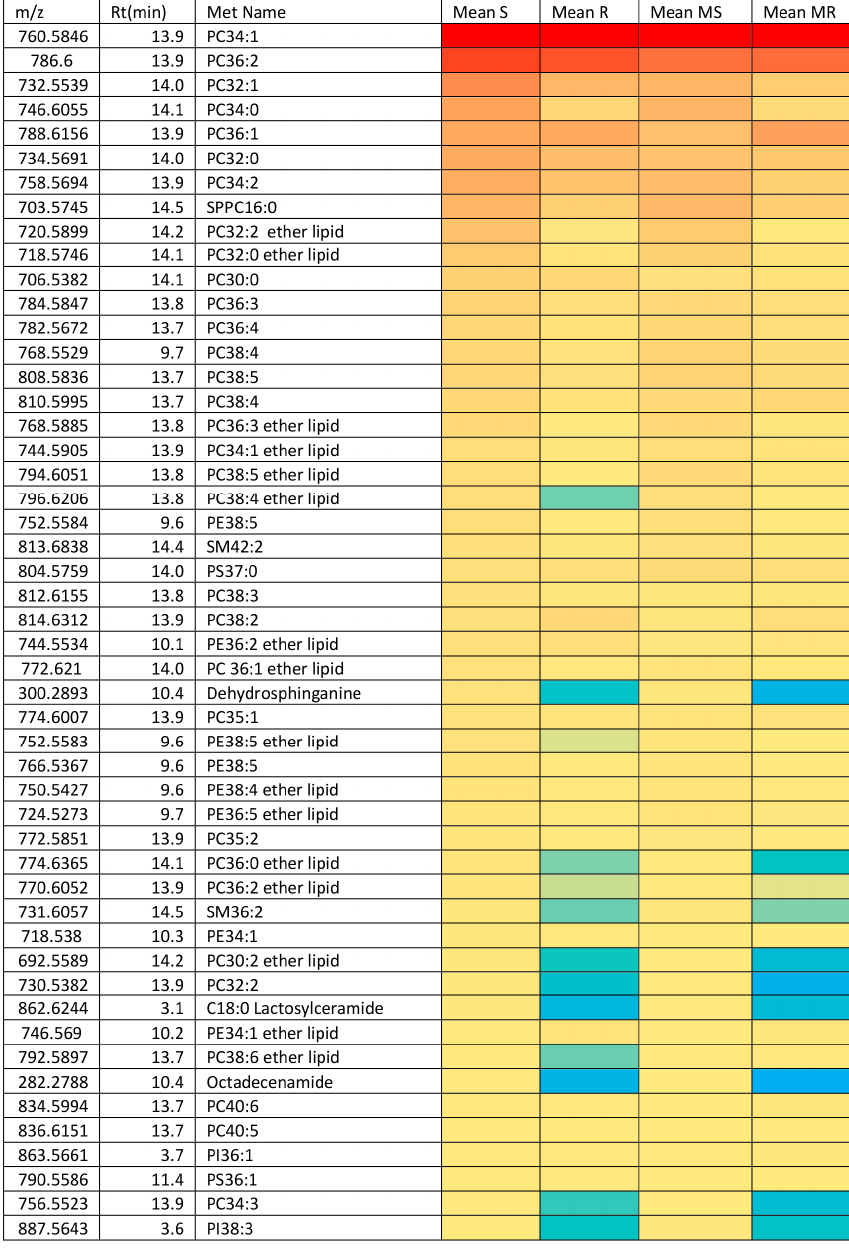
Figure 6. Heat Map showing the relative abundance of lipids in A2780 (S), A2780CR (R) and melittin treated (MS & MR) cells. Red = 5 × 10 7 , Yellow = 8% of highest value, Blue = 0%.